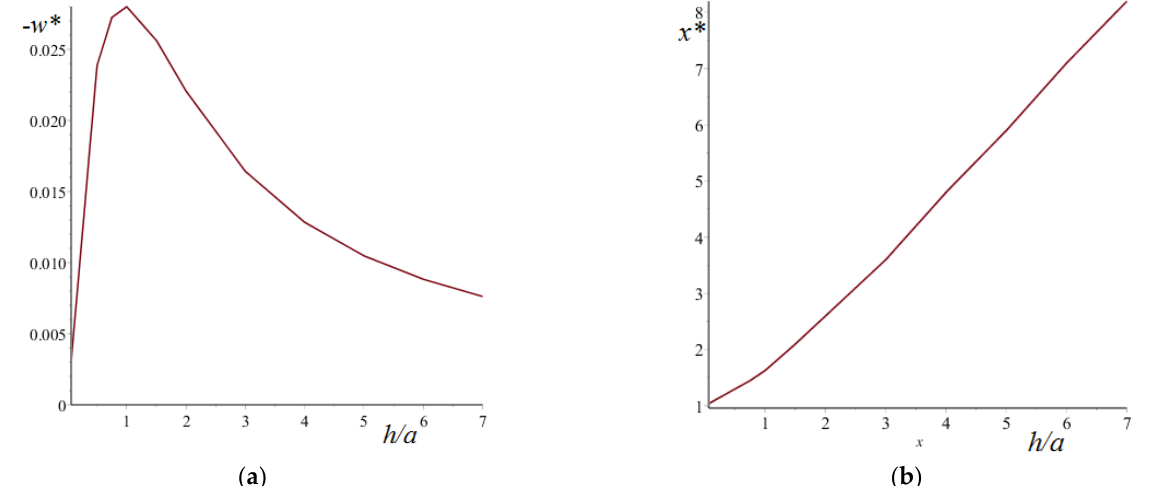
Figure 8. Dependences of w ∗ ( a ) and x ∗ ( b ) on the thickness of the compliant layer. E E 1 w ∗ = w , x ∗ = x / a . a q